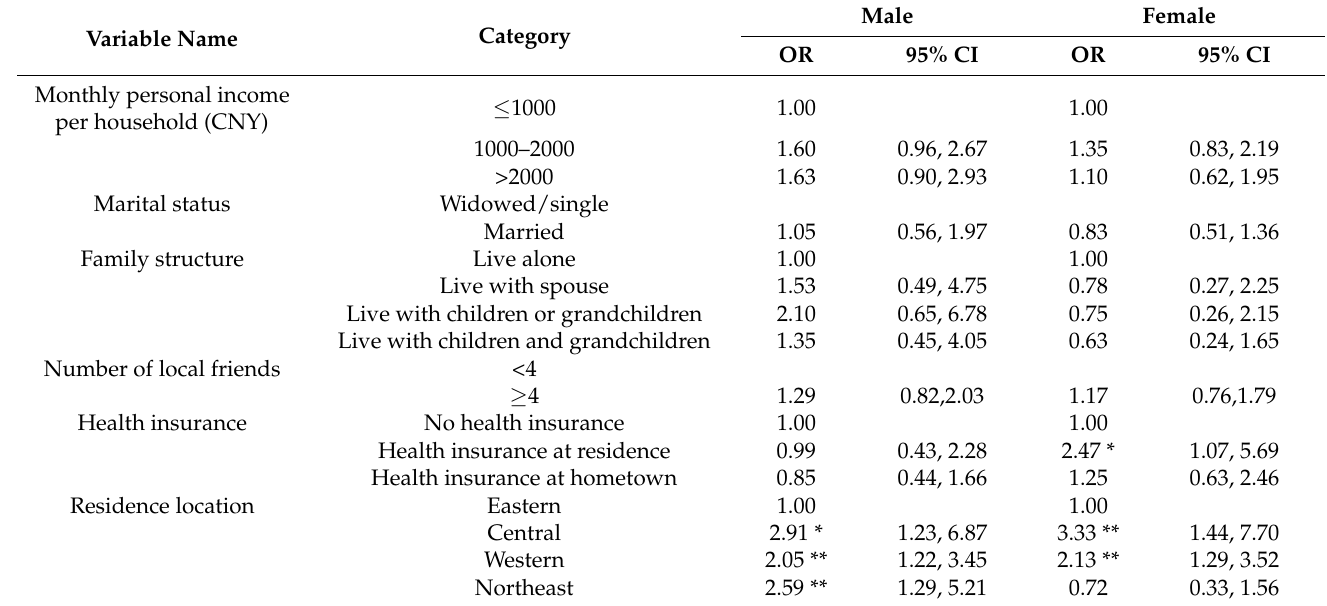
Table 4. Multivariate logistic regression on factors associated with enrolment in chronic disease